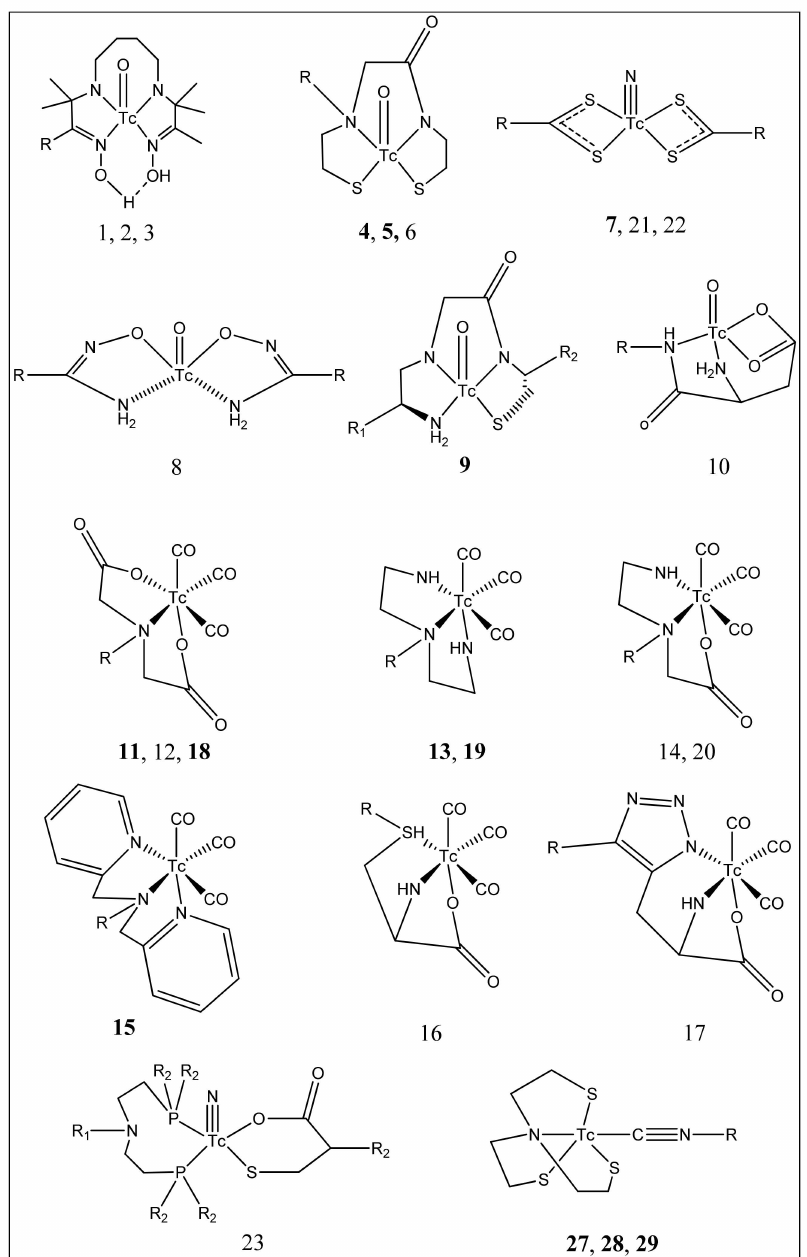
Figure 8. Structure of the di ff erent technetium complexes (the numbers in bold corresponding to structures experimentally